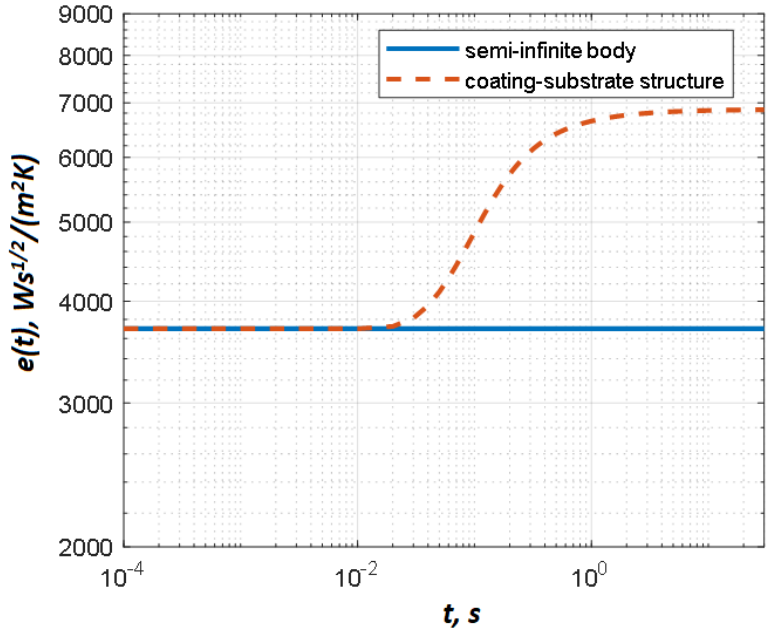
Figure 1. Determining thermal effusivity by Equations (3) and (4).